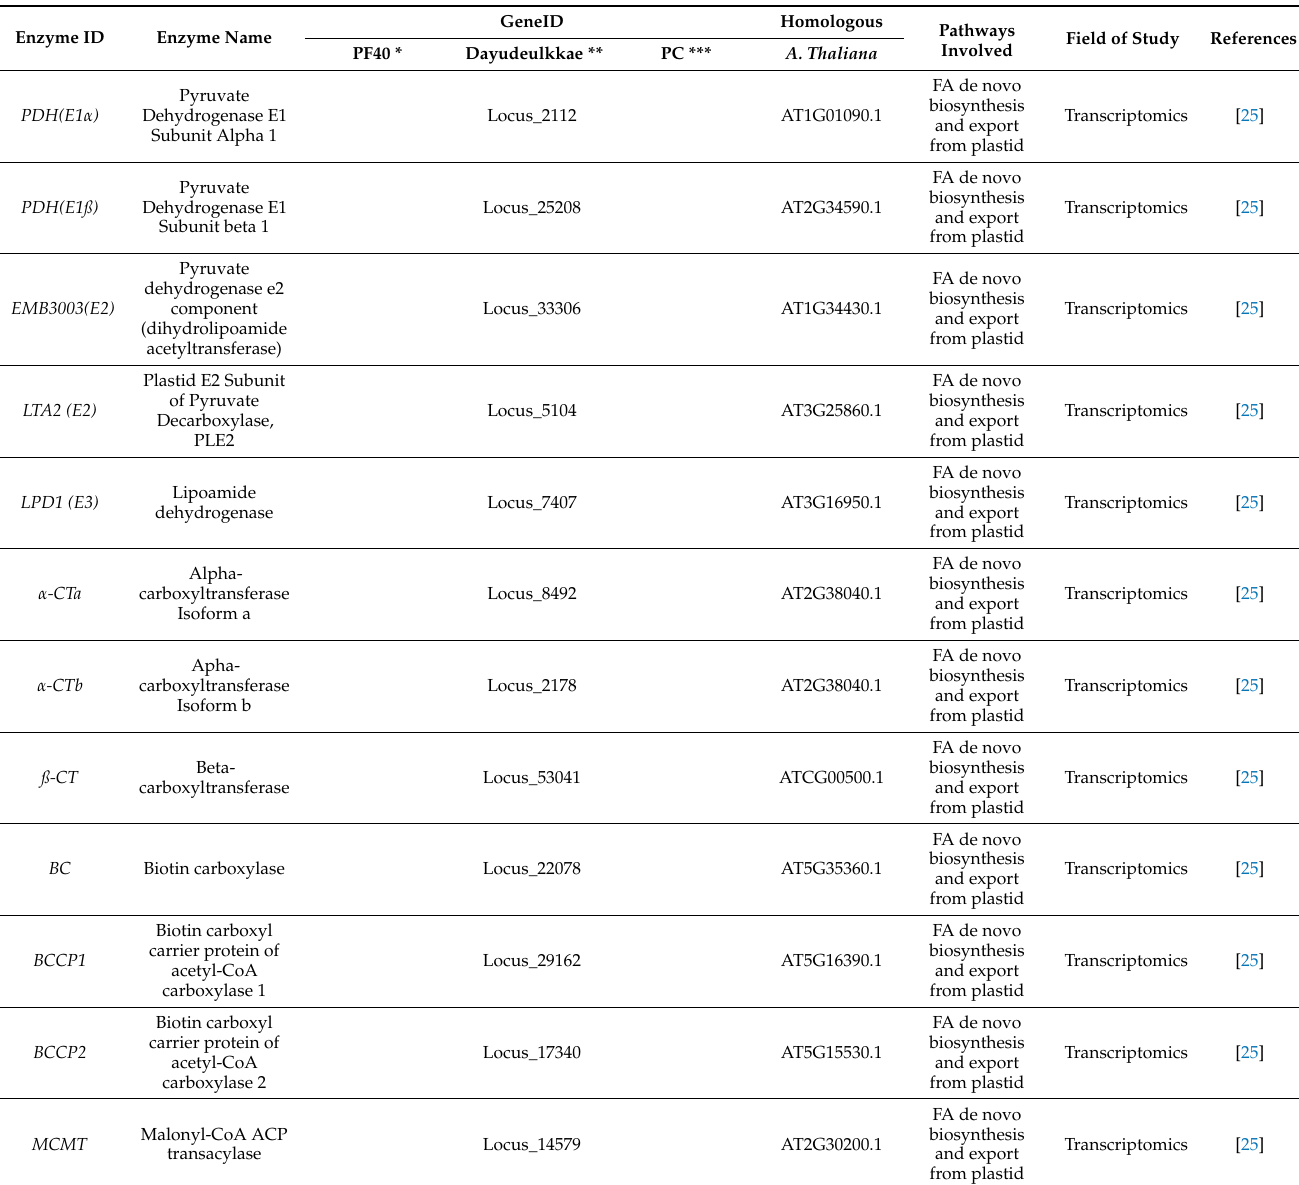
Table 1. Summary of Identified Major Genes Involved in Fatty Acid and Triacylglycerols Biosynthesis in Perilla